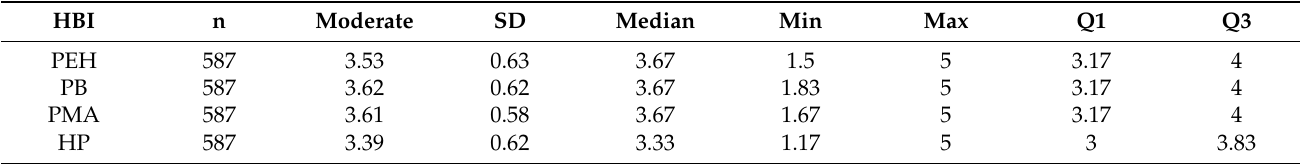
Table 4. The level of health behaviors division into